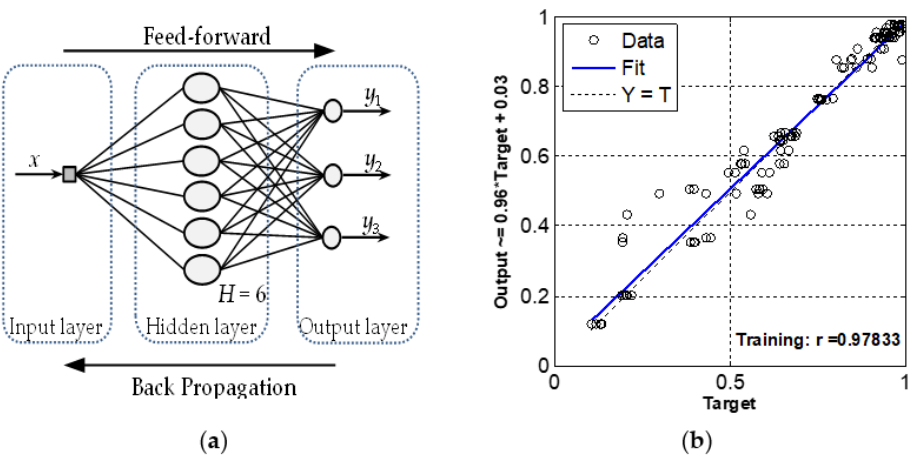
Figure 1. Network embedding based framework for App usage prediction. Figure 5. ( a ) Architecture of backpropagation neural network (BPNN):1-6-3; ( b ) correlation graphs for chosen